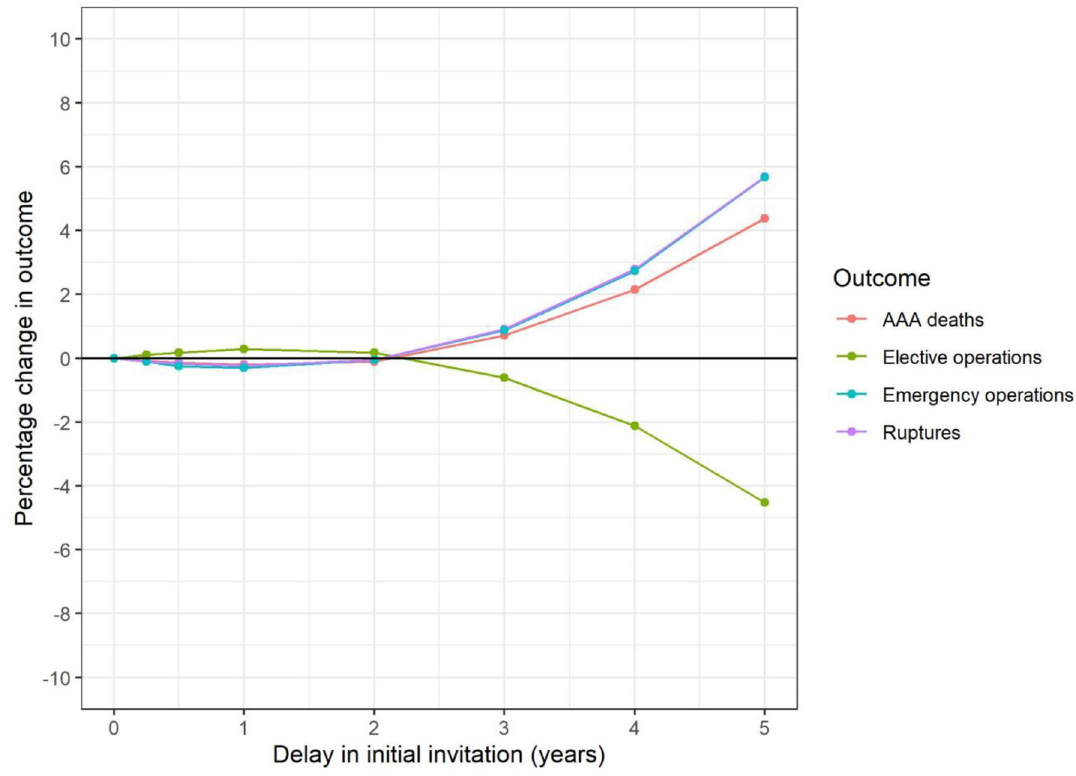
Fig 1. 65-year-old cohort: Change in key outcomes over varying delay to primary invitation (model I1).